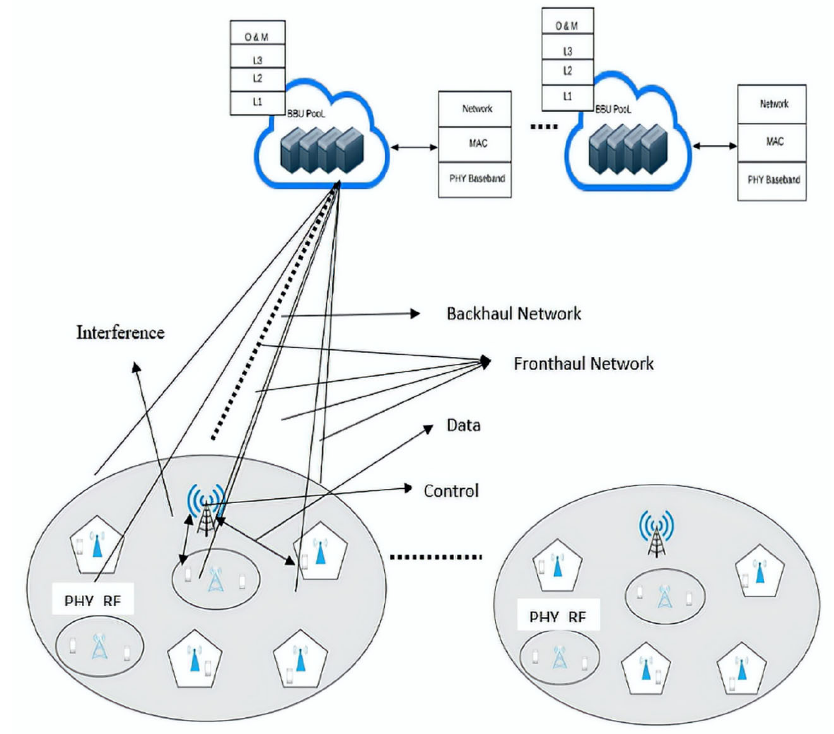
Figure 3. Resource Segmentation among BBU and RRH.